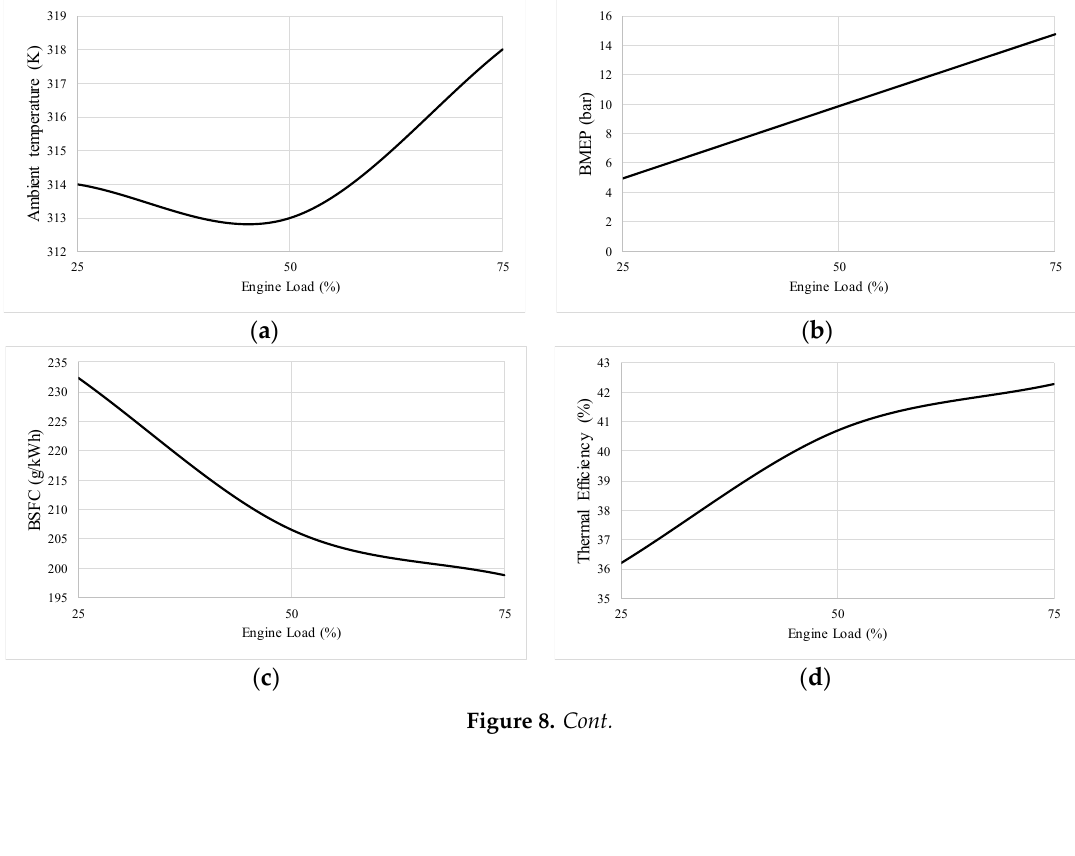
( h ) Figure 8. Variation of ( a ) ambient temperature; ( b ) BMEP; ( c ) BSFC; ( d ) thermal efficiency; ( e ) volumetric efficiency; ( f ) AFR; ( g ) firing pressure; ( h ) compressor pressure ratio for different engine loads. 5. Conclusions In this study, a data fitting technique is adopted, based on an optimization procedure for calibration purposes. An engine optimization model, coupling 1D engine simulation software and a nonlinear optimizer, is developed to simulate the performance of marine Genset and to fit the simulated in-cylinder pressure diagram with the experimental one. It has been concluded that: